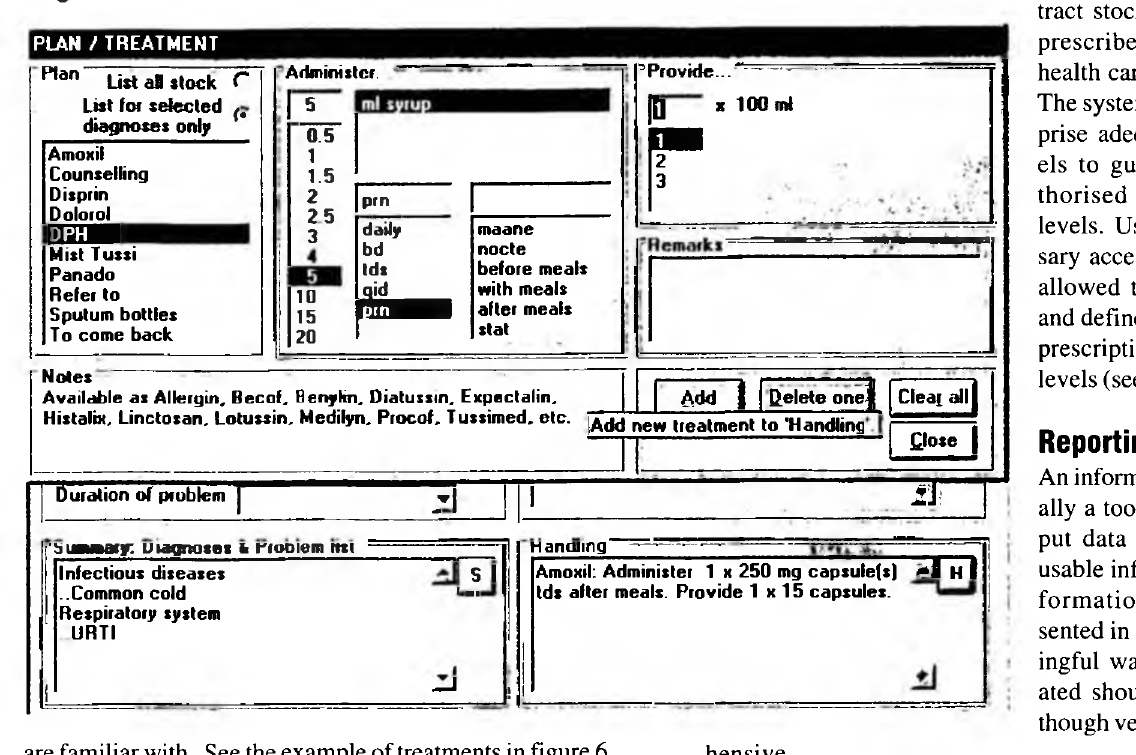
Figure 6 : Plan/treatment screen PUN I TREATMENT